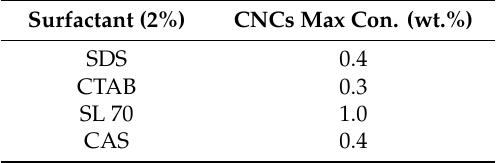
Table 3. Maximum CNCs dispersion capability of di ff erent surfactants.